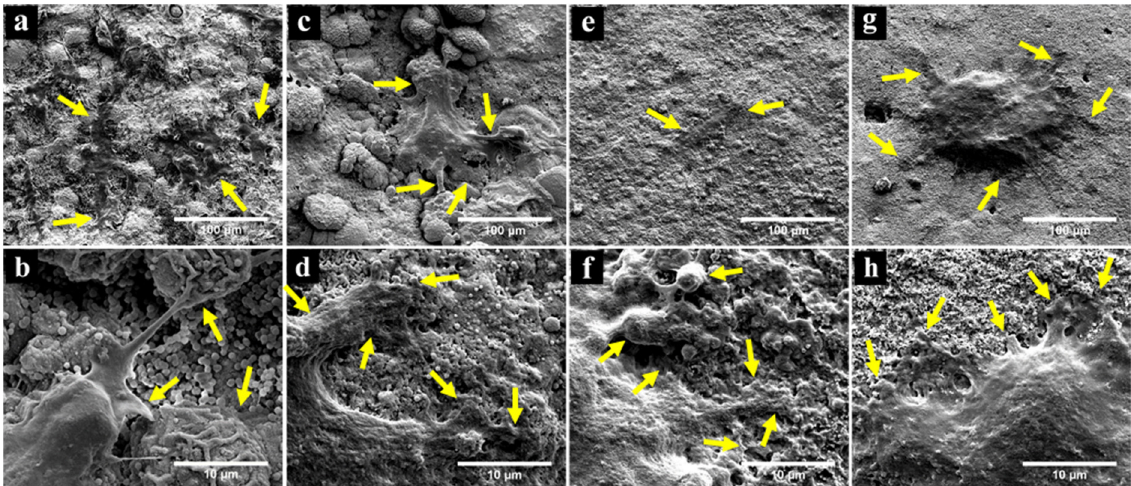
Figure 3. FESEM observation showing successful attachment and spread of SHED on ( a , b ) APC, ( c , d ) APC-0.6%CT, ( e , f ) APC-1.25%CT and ( g , h ) APC-2.5%CT after 3 days. Yellow arrows in upper images ( a , c , e , g ) focus on cell attachment and extension of cytoplasmic processes. Yellow arrows in high-magnification images ( b , d , f , h ) point to the interface between lamellipodial and filopodial protrusions and the material surface. Magnification of 1000× (upper) and 10,000× (lower).